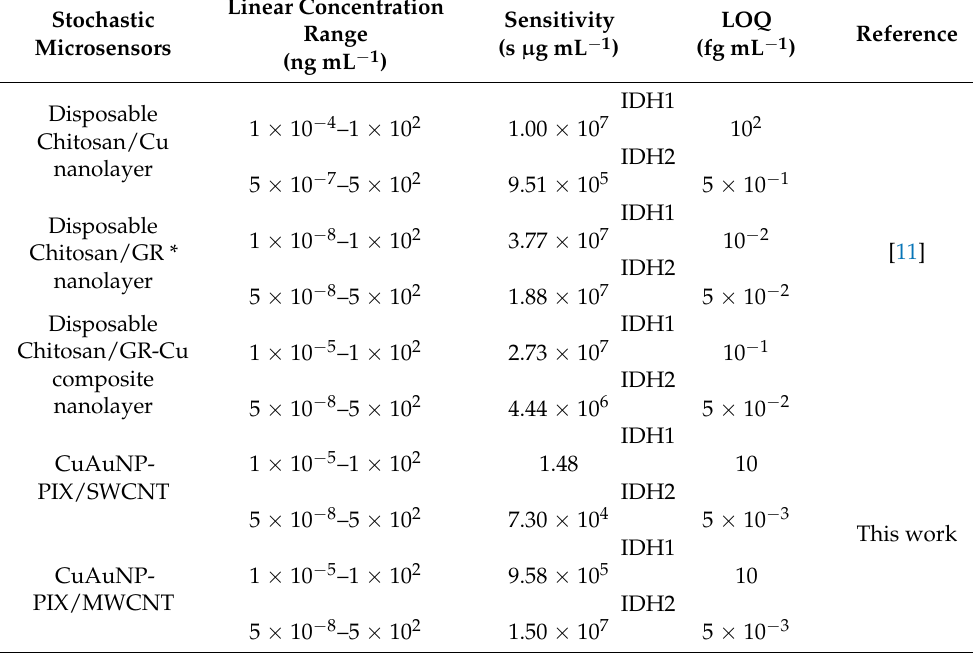
Table 3. The selectivity of the stochastic microsensors. IDH1 IDH2 Heregulin- α Dopamine Epinephrine Levodopa